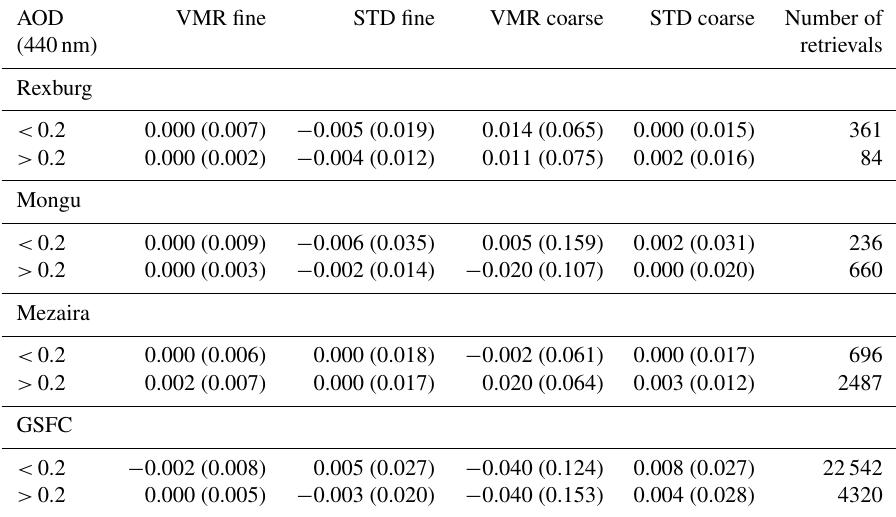
Table 3. Average values and standard deviations (in parentheses) of the difference in volume median radius (VMR) in microns and width of particle size distribution (STD) retrievals from inversions using STD and REL assumptions on IPRI smoothness constraints. The difference is defined as REL minus